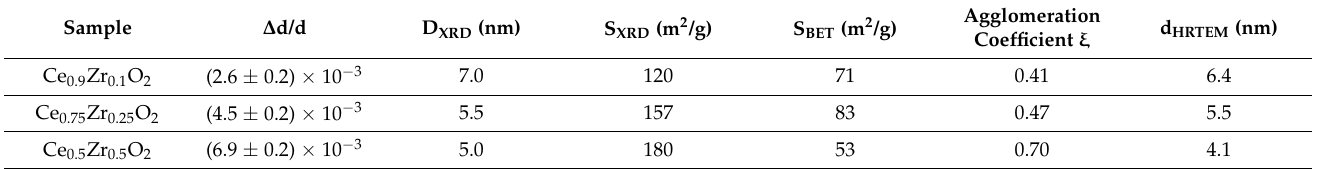
Table 3. Average crystallite sizes and microstrain values according to XRD data, specific surface areas calculated from XRD-derived crystallite sizes and determined by BET method, agglomeration coefficients, and average crystallite sizes according to HRTEM data.